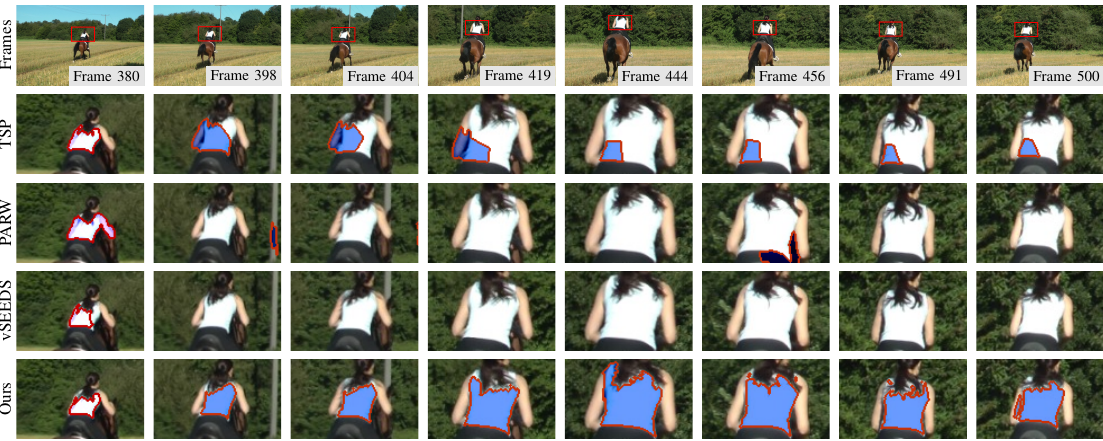
Figure 11. Segmentation results of a moving target of varying size. Only the regions of interest defined by red rectangles in the first row are plotted in the last three rows. This sequence is from